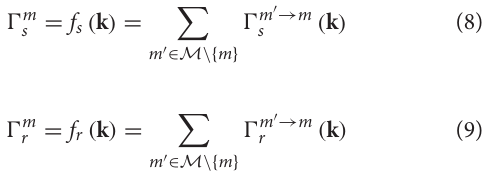
delays in Equation (9). Here, the notation Ŵ m ′ → m describes the additional delays caused by mode m ′ on mode m , where the → operator indicates the direction of